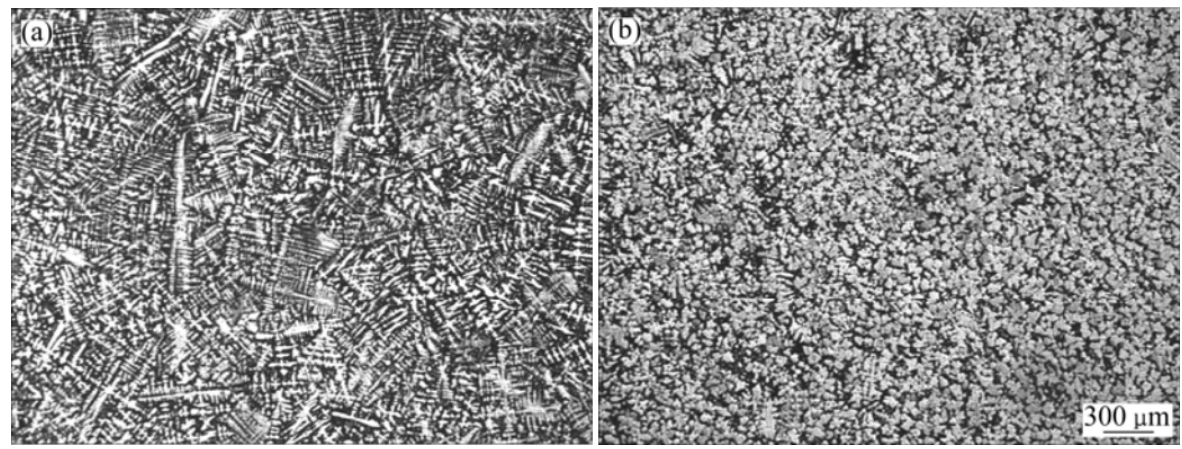
Figure 22. As-cast microstructures of superalloy IN718 without PMF ( a ) and with PMF ( b )